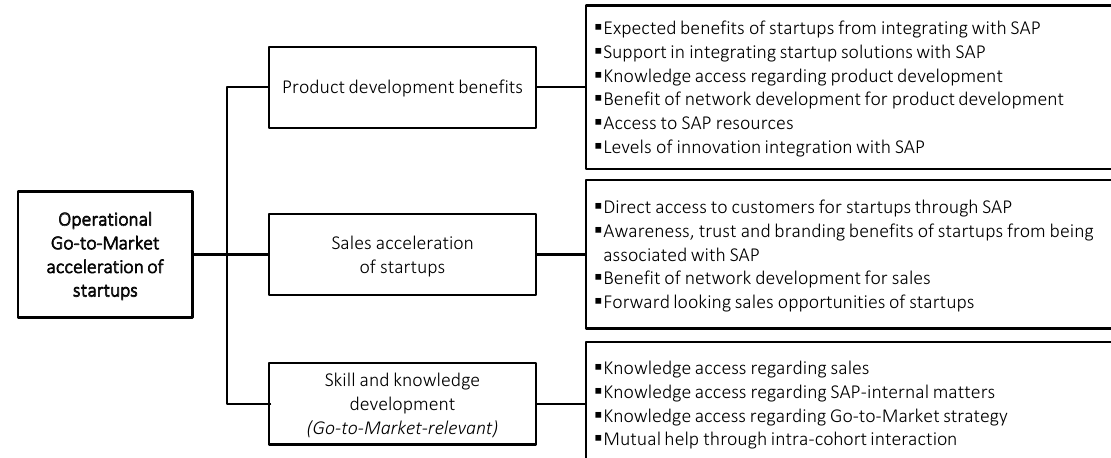
Figure 3. Operational Go-to-Market acceleration of